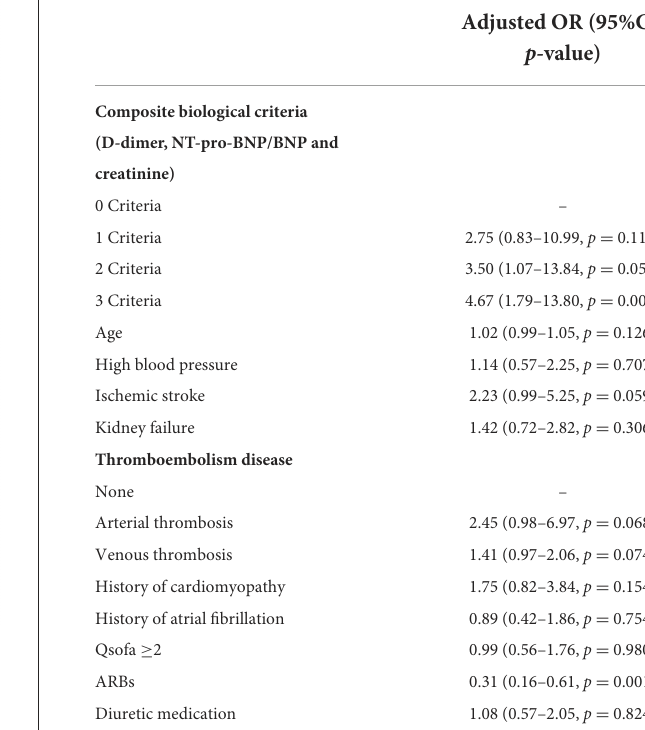
TABLE 3 Analysis for LST decision in COVID-19 during the first wave of pandemic.